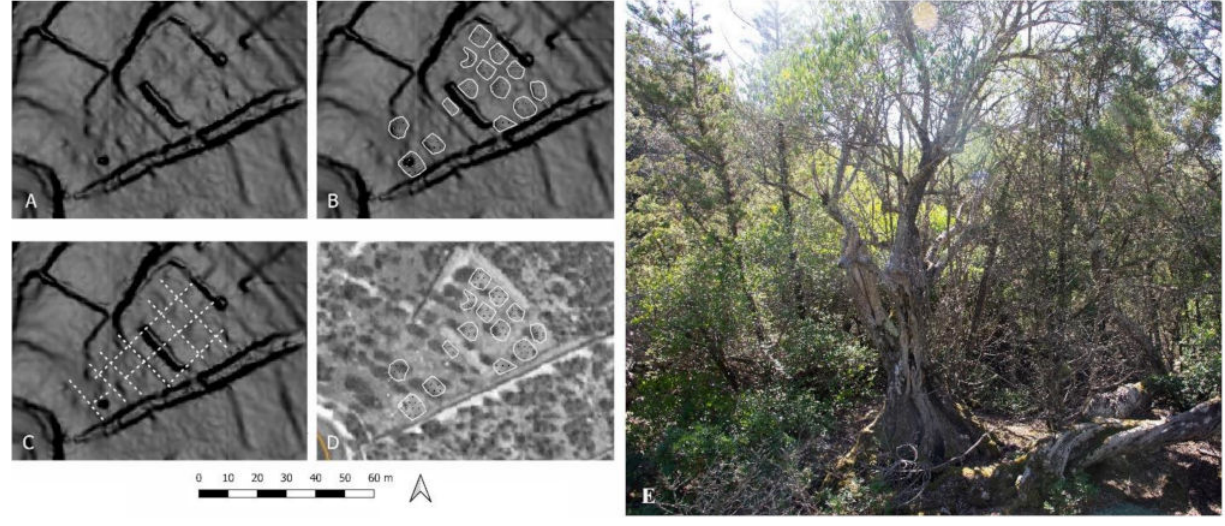
Figure 16. ( A – C ) Grid of platforms measuring 8 by 8 m as seen in the dense_veg filtered DFM (visualization: slope). ( D ) Overlying the outline of the platforms with the 1953 Digital Orthophoto Map shows a tree on each platform (source: State Geodetic Administration Geoportal/Geoportal Državne geodetske uprave—geoportal.dgu.hr). ( E ) A live tree in this area (Photo: M. Doneus, 2 September